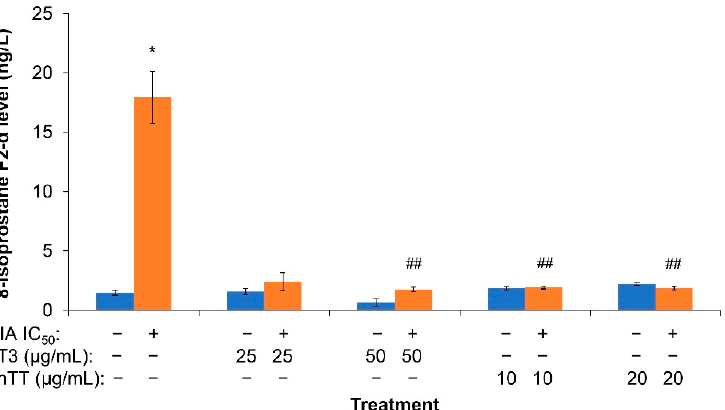
Figure 4. The 8-isoprostane F2- α level of SW1353 chondrocytes treated for 24 h with AnTT or PT3 alone and in combination with MIA (IC 50 31.5 µ M). All results were from 3 independent experiments. Two technical replicates were used during measurement according to manufacturer’s instruction. The data were displayed in mean ± SEM. * indicates a significant difference of p < 0.05 compared to VC. ## indicates a significant difference of p < 0.01 compared to the group treated with MIA